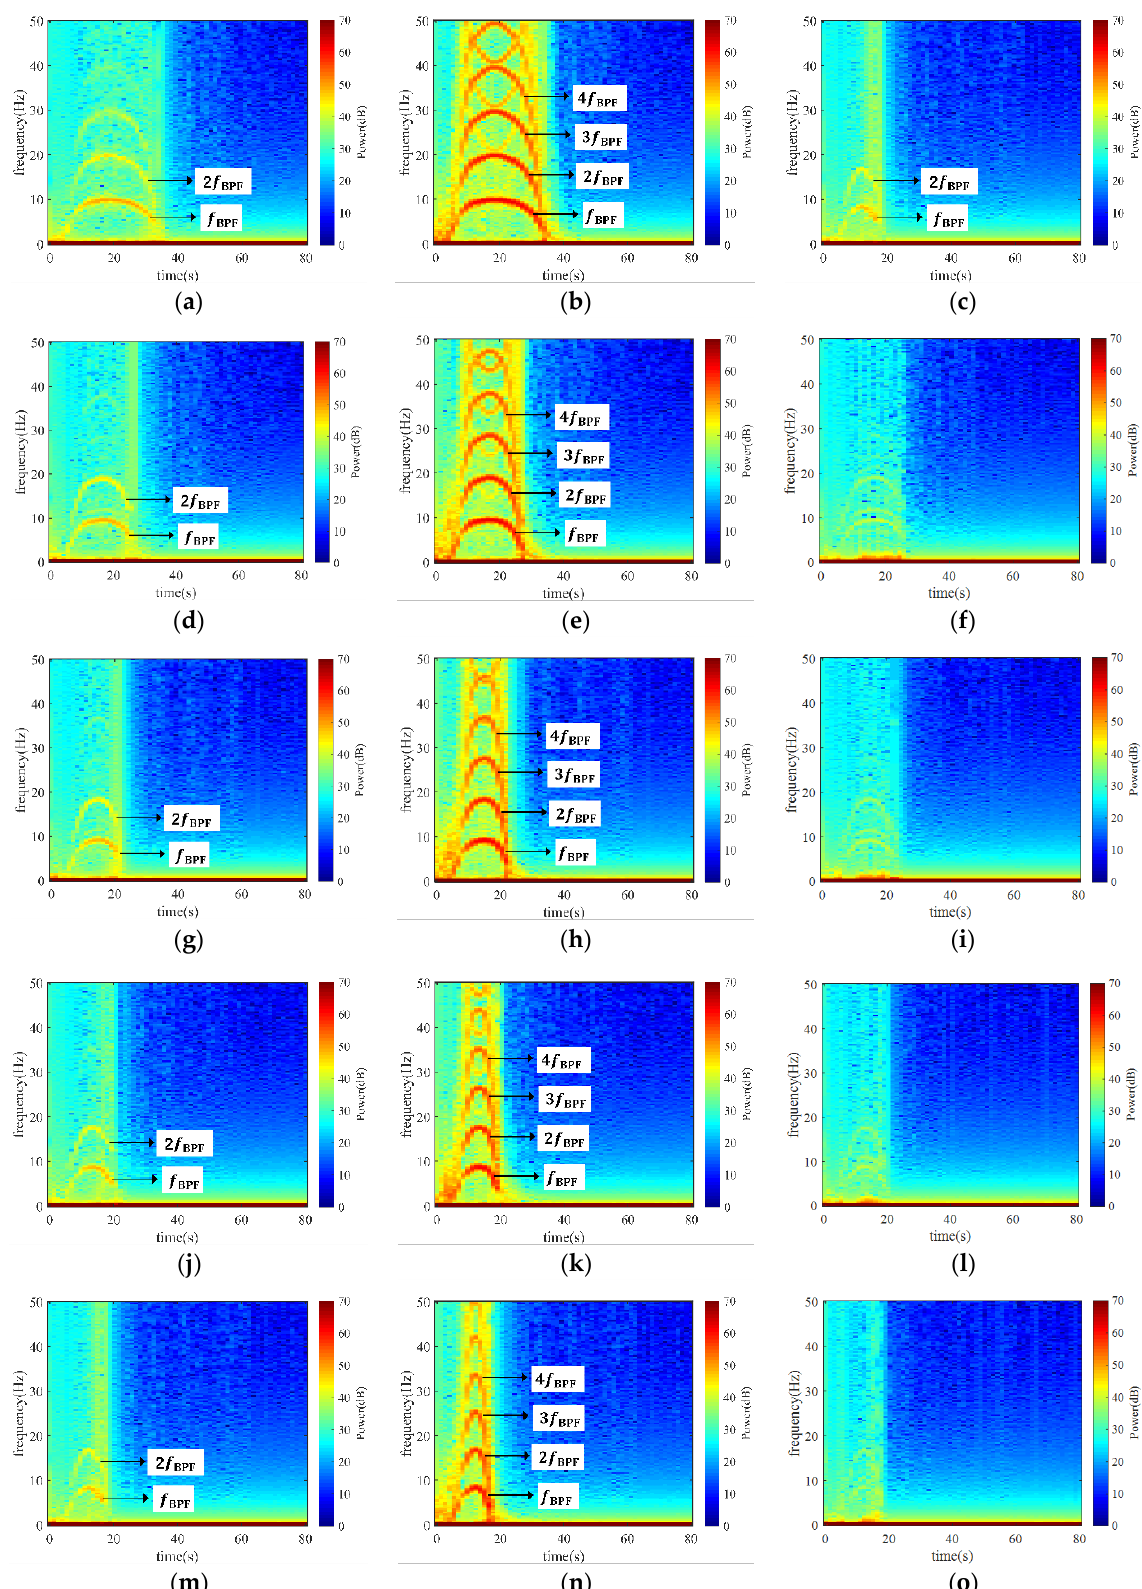
Figure 11. Distribution of the three monitoring points.